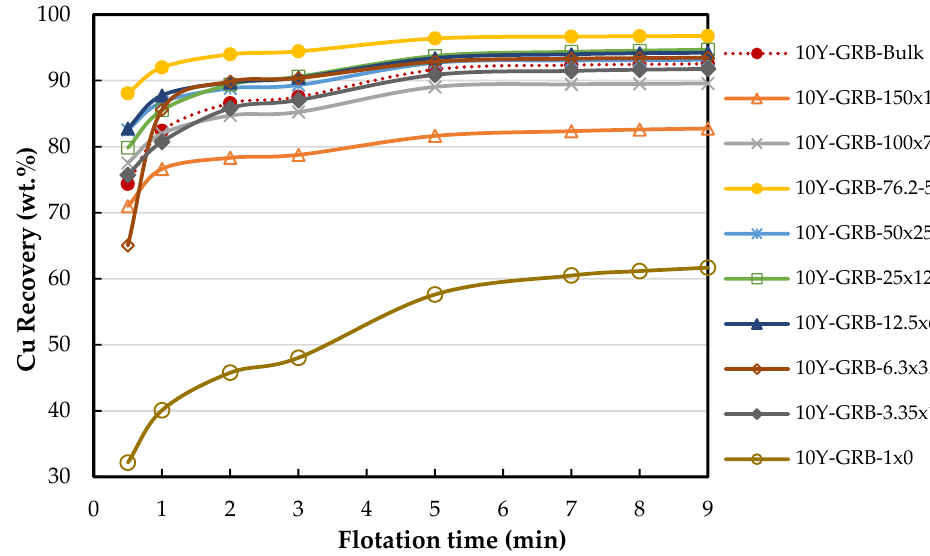
Figure 12. Kinetic rougher flotation tests for sample 10Y-GRB-Bulk and its size fractions. The sample 10Y-GRB-76.2x50 exhibited the highest Cu recovery (96.8%), probably due